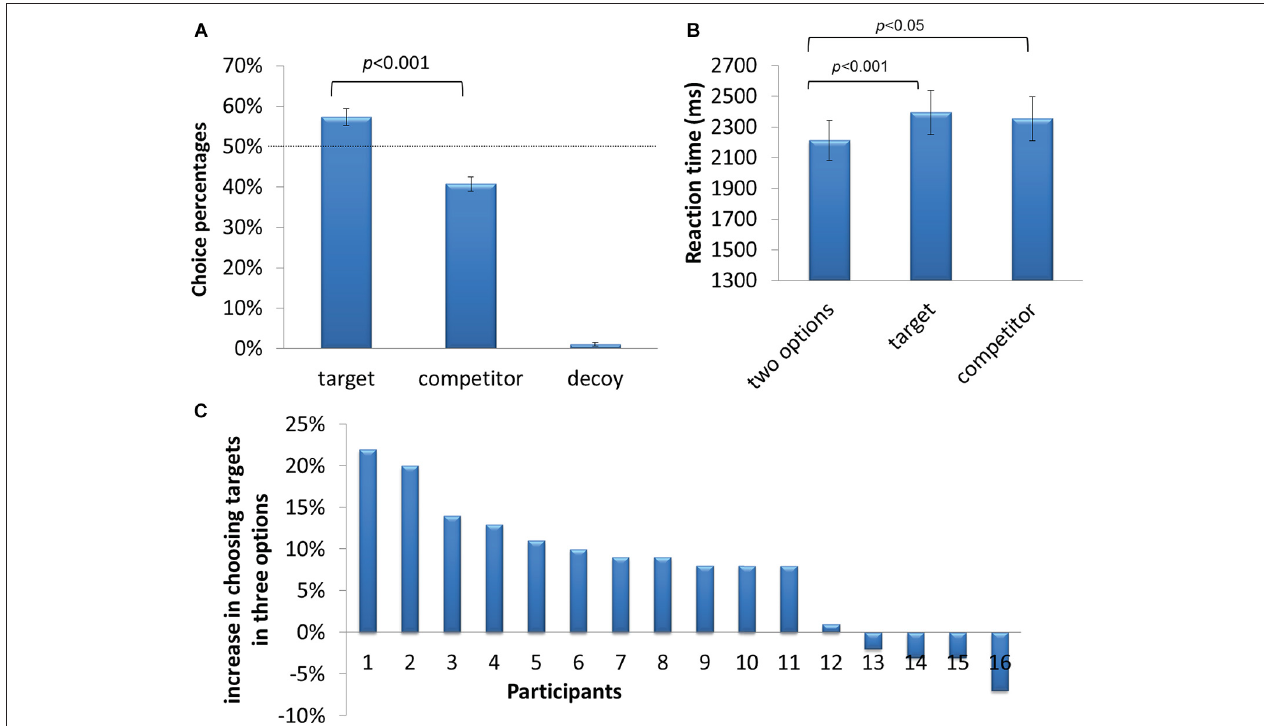
FIGURE 2 | Behavioral results. (A) Percentage of trials in which participants chose the target, competitor and decoy. (B) Reaction time of choosing the target, competitor and decoy. (C) Individual differences in susceptibility to the decoy effect, i.e., the percentage difference between choosing the target as compared to